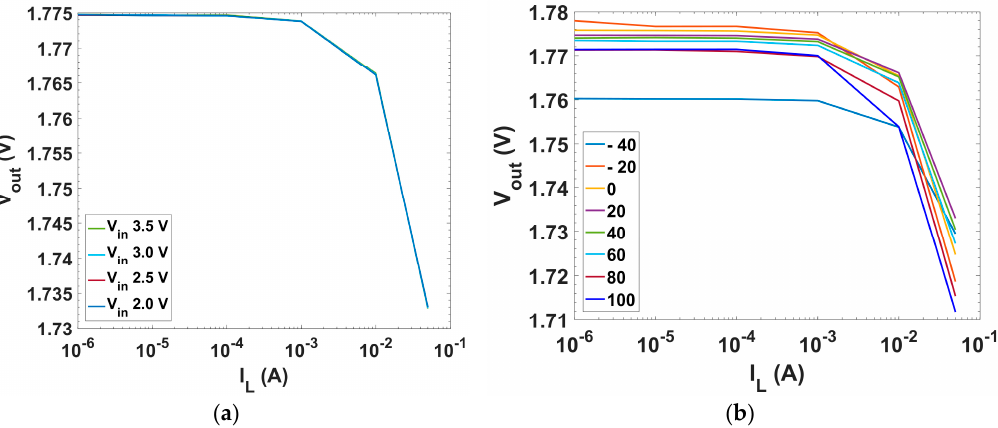
Figure 11. Load regulation characteristic, i.e., output voltage vs. load current: ( a ) for different input voltages; and ( b ) for different temperatures with 2.5 V input voltage.